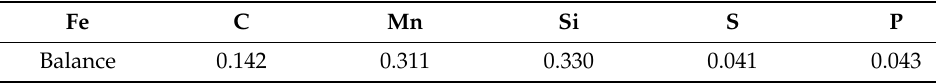
Table 1. Chemical composition of the Q235 steel